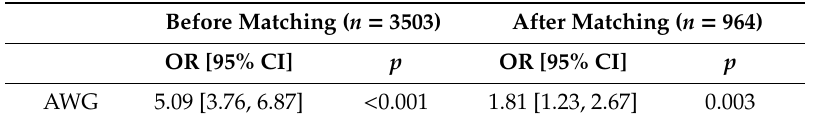
Table 3. Univariate logistic regression analysis using NAFLD as the dependent variable. Before Matching ( n = 3503) After Matching ( n = 964) OR [95% CI] p OR [95% CI] p AWG 5.09 [3.76, 6.87] < 0.001 1.81 [1.23,